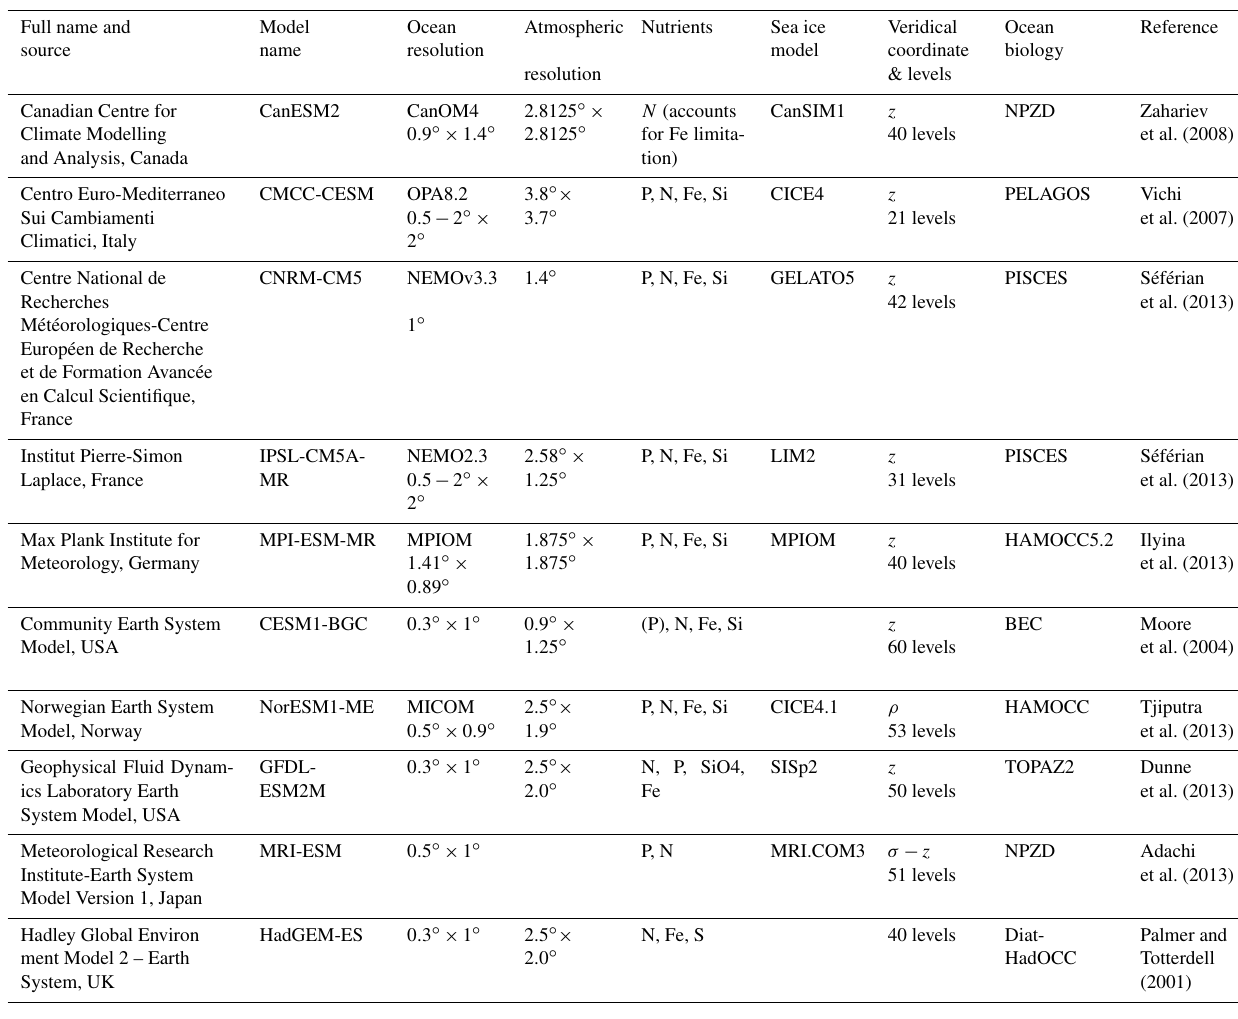
Table 1. A description of the 10 CMIP5 ESMs that were used in this analysis. It shows the ocean resolution, atmospheric resolution, and available nutrients for the biogeochemical component, sea-ice model, vertical levels and the marine biogeochemical component for each